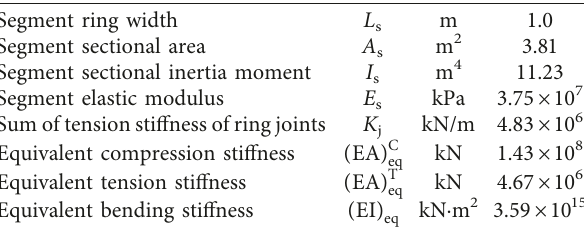
Figure 11: Ground and structure conditions in numerical simulations. Table 1: Equivalent stiffness of the shield